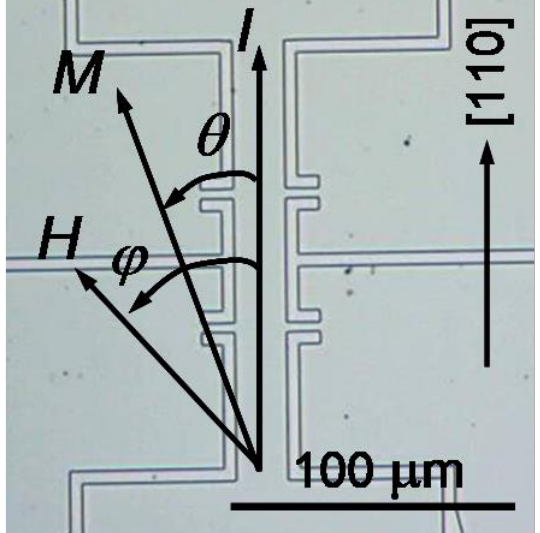
Figure 1. Microscopic image of a micro-Hall-bar tailored from the investigated (Ga,Mn)(Bi,As) layer along the [110] crystallographic direction and configuration for the PHE measurements. θ and ϕ denote angles between the current direction I and the magnetization vector M and applied in-plane magnetic field H , respectively.